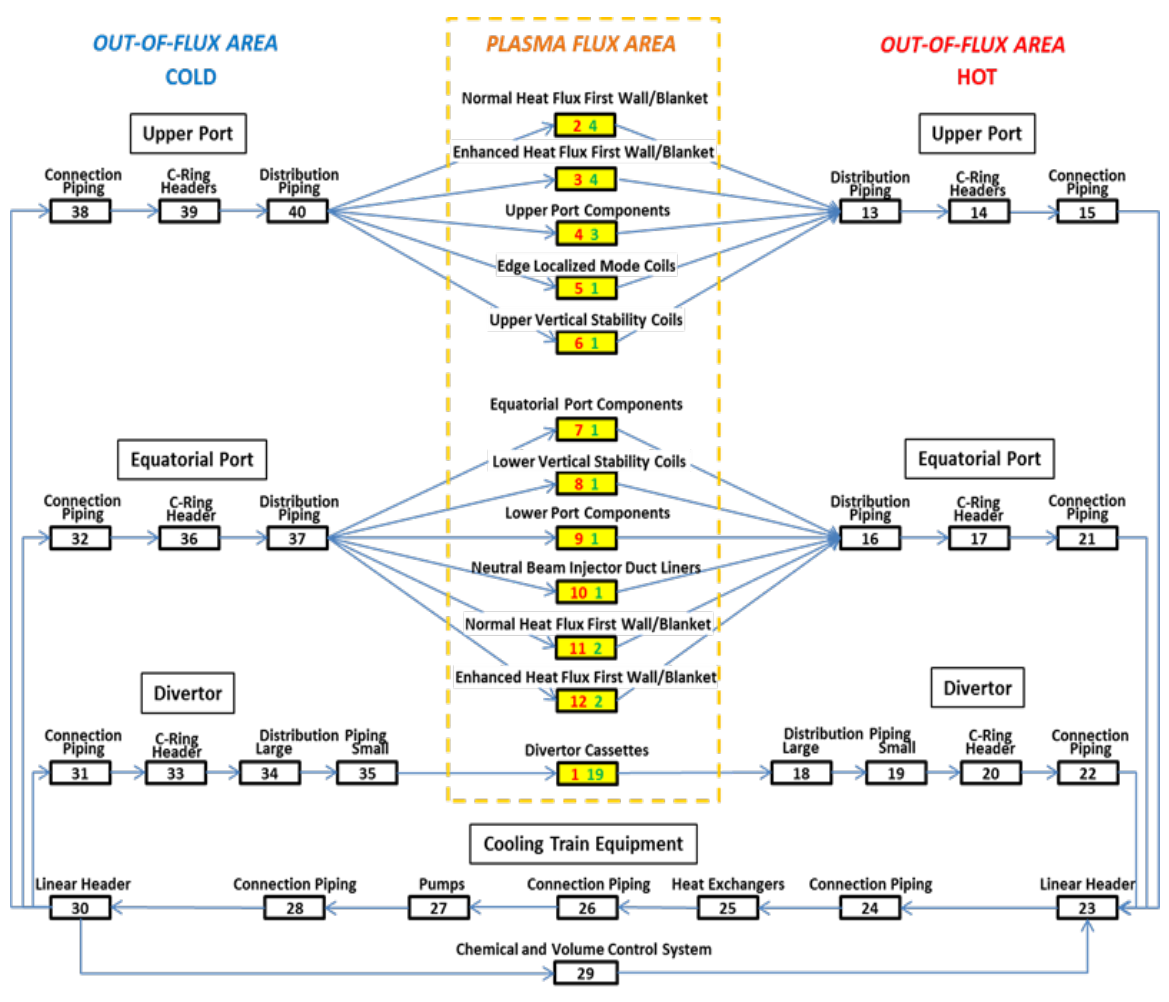
Figure 29. Modularization of the IBED PHTS of the ITER for Radiolysis Assessment [1]. © 2017 OLI Systems, Inc.